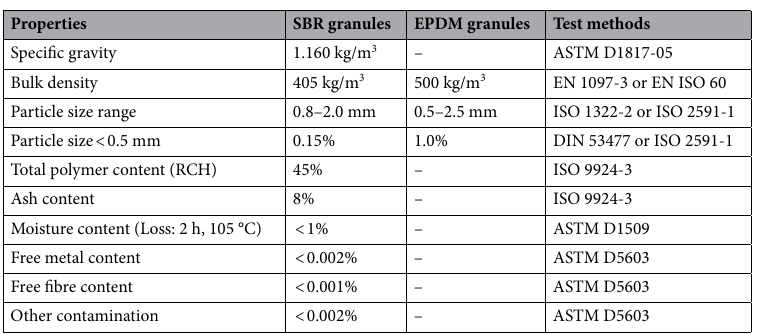
Table 1. Some physical parameters of the tested SBR and EPDM granules (data from the Technical Data Sheets provided by the